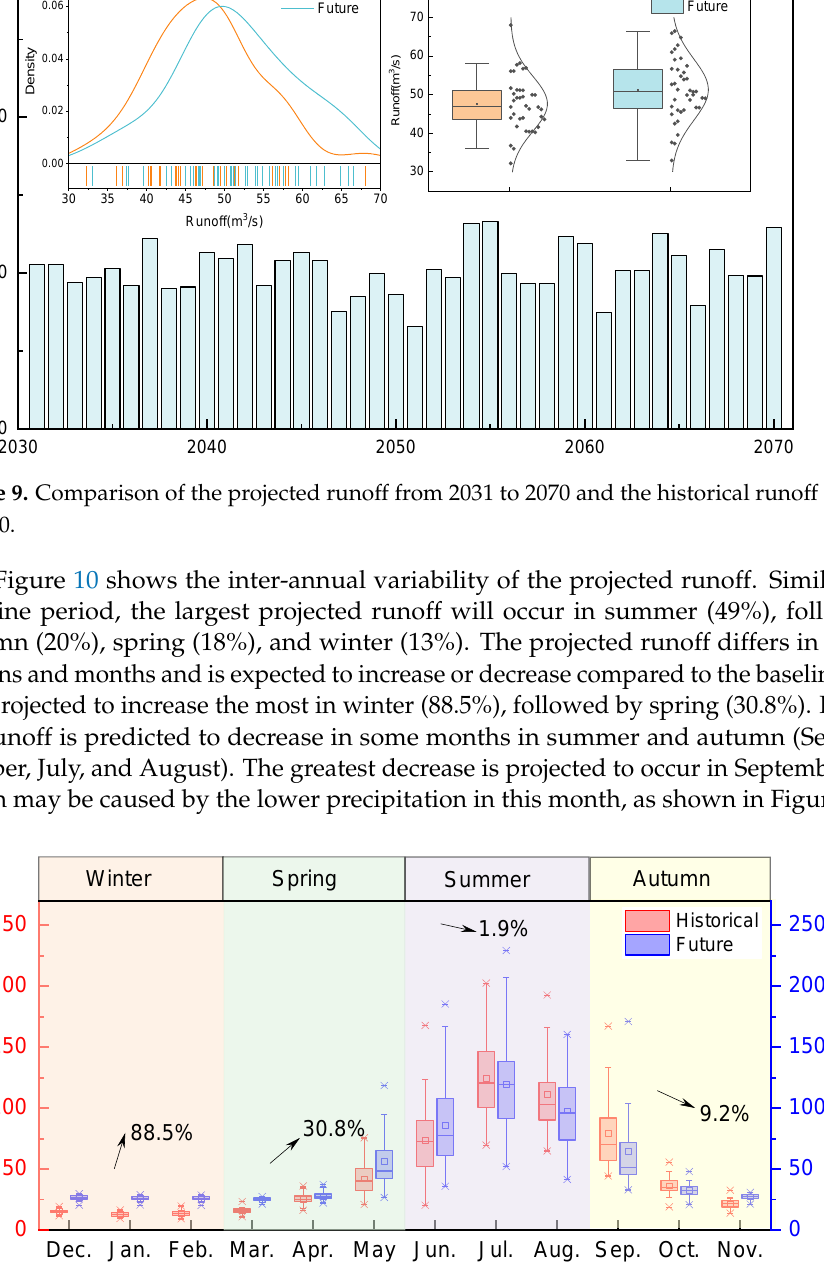
Dec. Jan. Feb. Mar. Apr. May Jun. Jul. Aug. Sep. Oct. Nov. Figure 10. The inter-annual projected and historical runoffs in the study area. The projected runoff extremes are also considered since they are more sensitive to climate change at the regional scale. Figure 11 and Table 4 show the statistical results of the projected high- and low-flow series. The mean value of the high-flow series is projected to decrease slightly by 3%, the maximum value (229.3 m 3 /s) is predicted to increase by 13%, and the minimum value (67.15 m 3 /s) is predicted to decrease by 15%. The coefficient of variation is projected to increase by 27%, indicating an increase in the degree of variation of the high flows. The data suggest an increased flood risk during the wet season, resulting in challenges in water resource allocation and management.